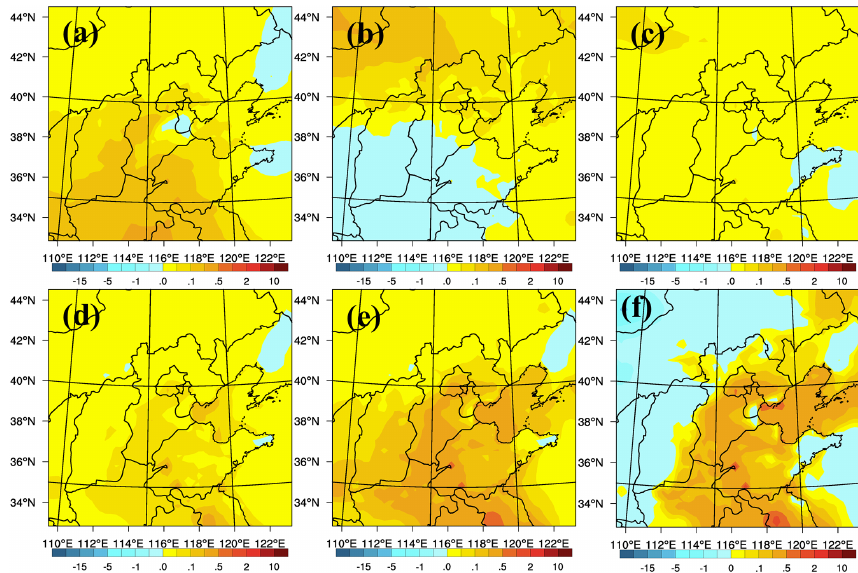
Figure 7. Monthly mean changes of sulfate (a) , nitrate (b) , ammonium (c) , BC (d) , OC (e) , and PM 2 . 5 (f) due to temperature